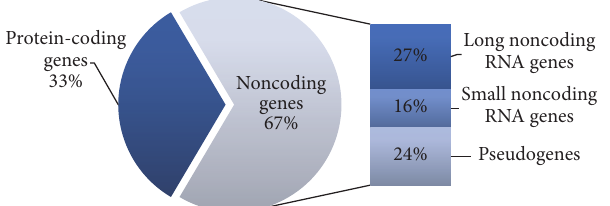
Figure 1: Schematic illustration of human genome presented by the Encyclopedia of DNA Elements Consortium (ENCODE). Detailed description of gene representation in the main